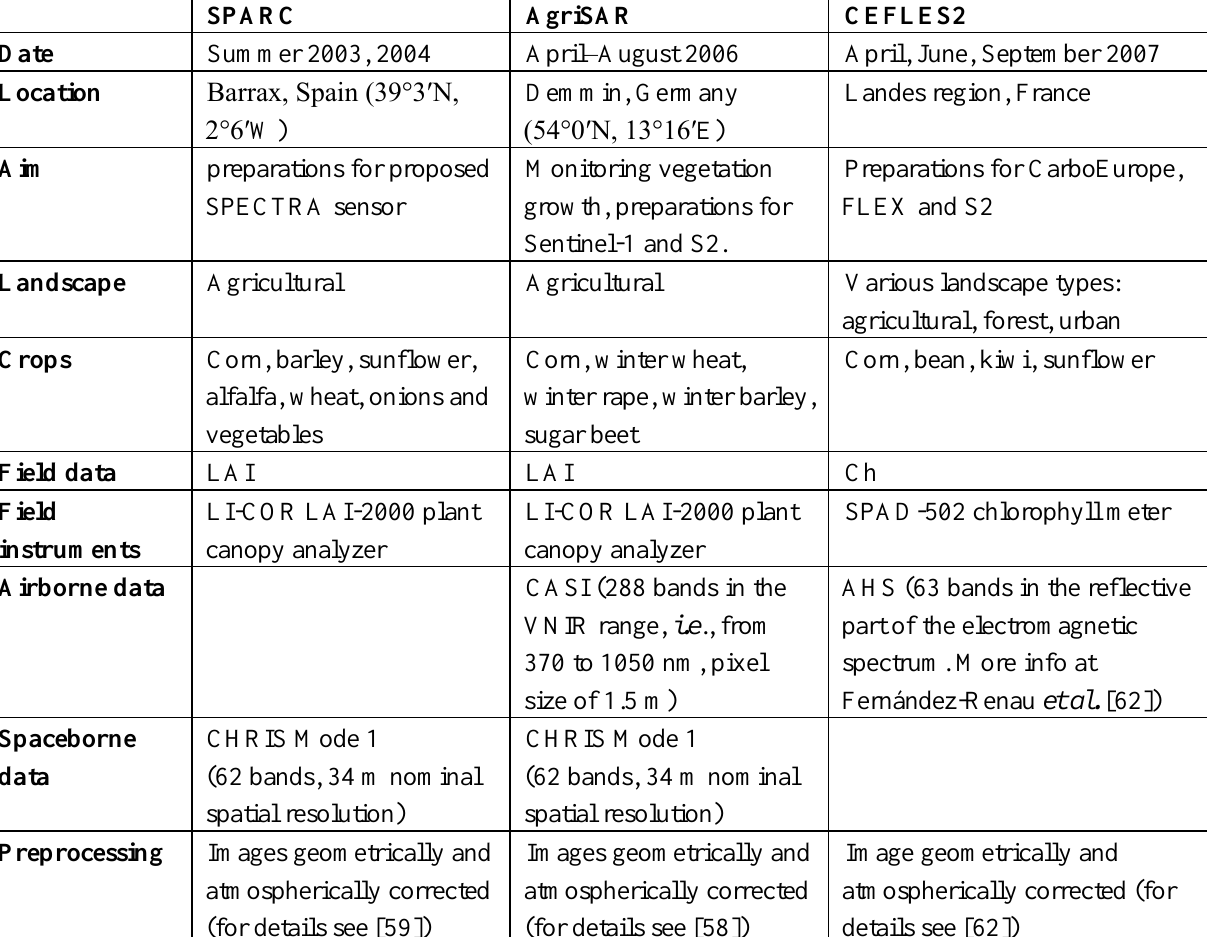
Table 2. Specifications of the campaigns. Only the data used in this work is